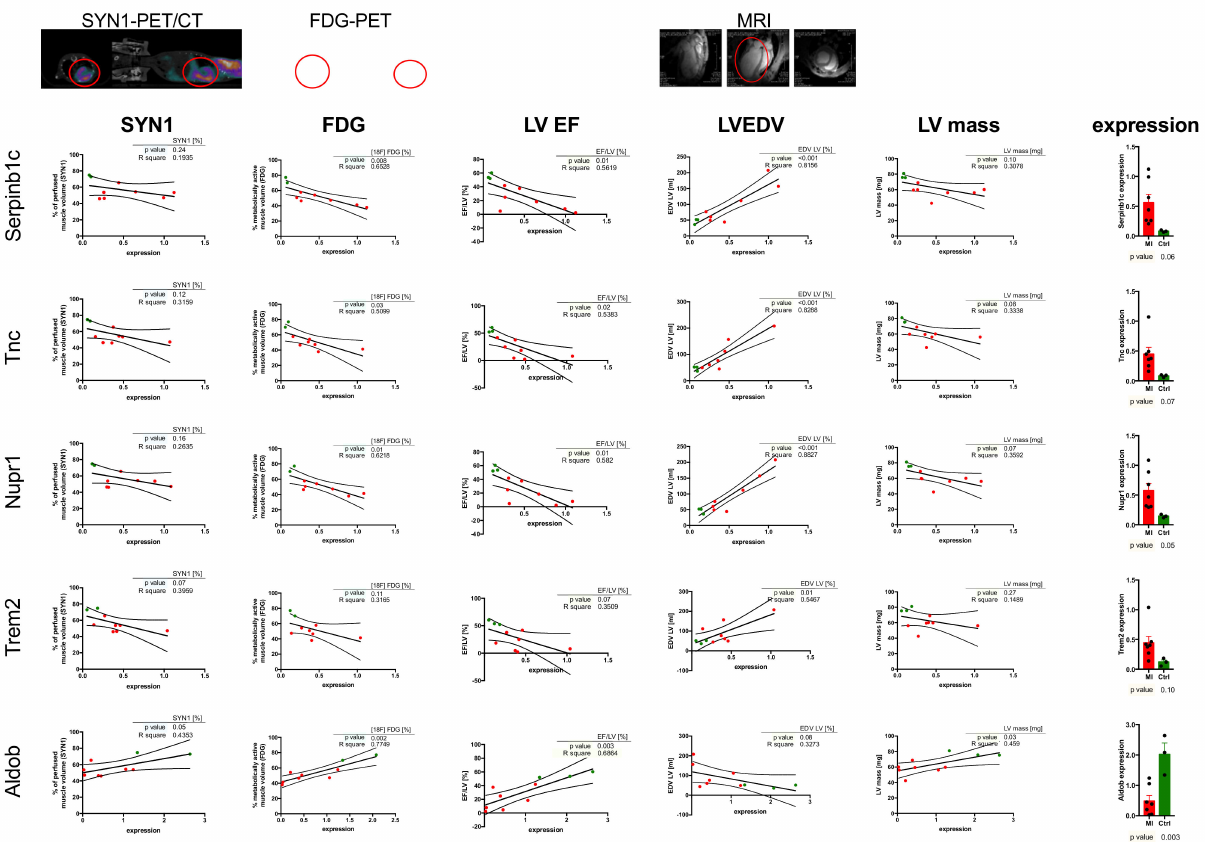
Figure 3. Correlation between gene expression and heart perfusion, metabolic and functional parameters. Above the graphs: SYN1-PET/CT scans of mice in the abdominal and lateral positions. FDG-PET-PET scans of the same mouse in the abdominal and lateral positions. MRI imaging— heart scans in three planes. Red circles indicate visible losses of marker accumulation and places of myocardial impairment. SYN1, [ 18 F]-FDG and MRI parameters (LV EF, LVEDV, LV mass) have been correlated with expression pattern of selected genes ( Serpinb1c, Nupr1, Trem2, Tnc and Aldob ). For each correlation, a linear regression analysis was performed. Charts include 95% CI (dashed line). Values p ≤ 0.1 are considered to be significant. Detailed data discussion in the main